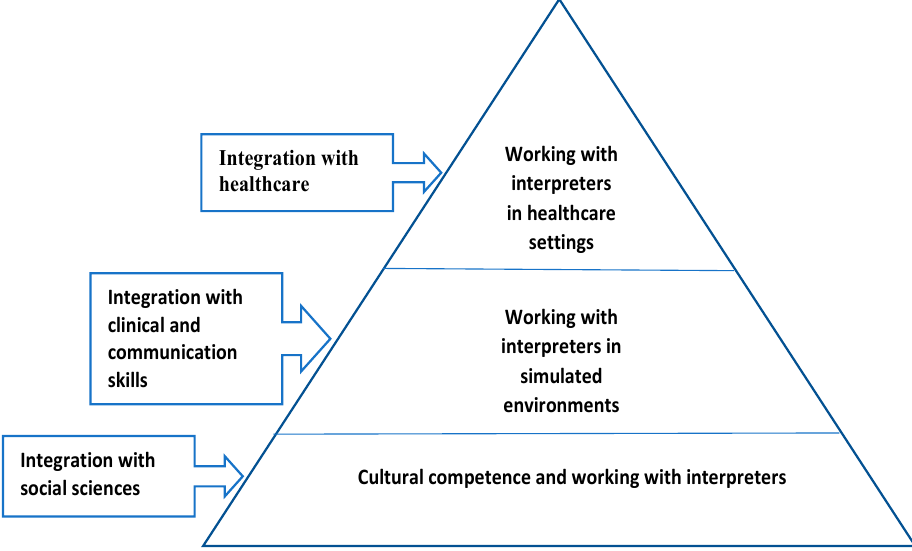
Figure 2. Longitudinal integration of the use of interpreters in medical education.